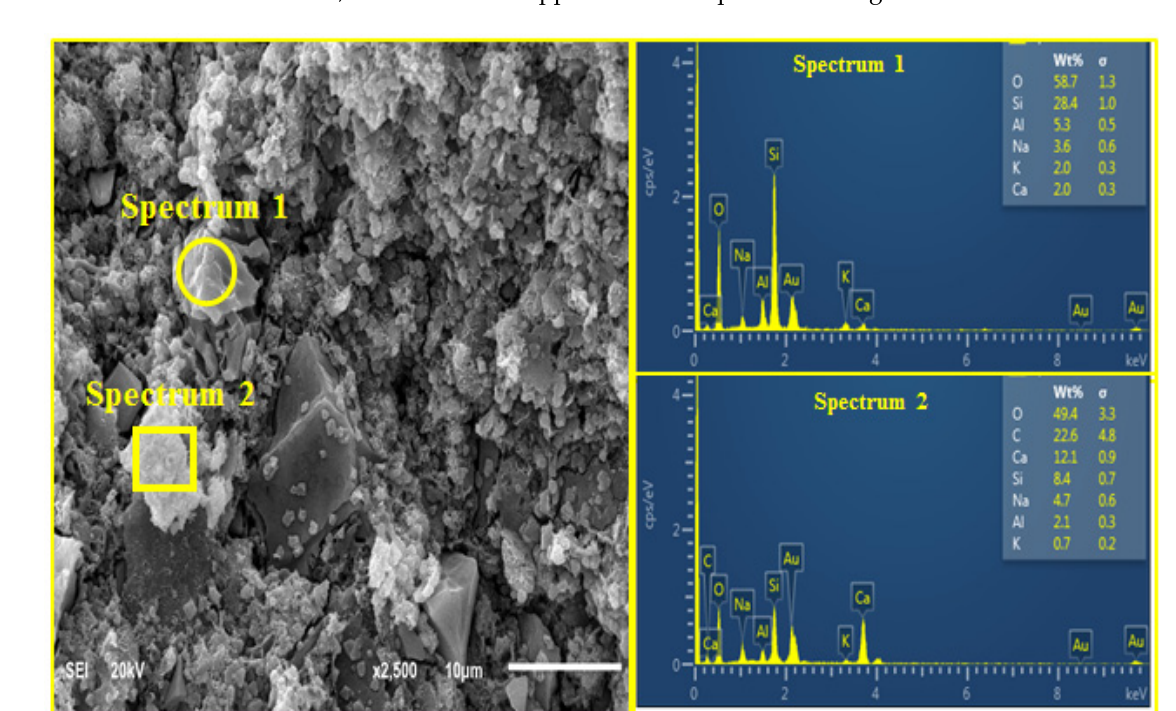
Figure 9. SEM + EDX result of AANL activated using only 10 M NaOH.